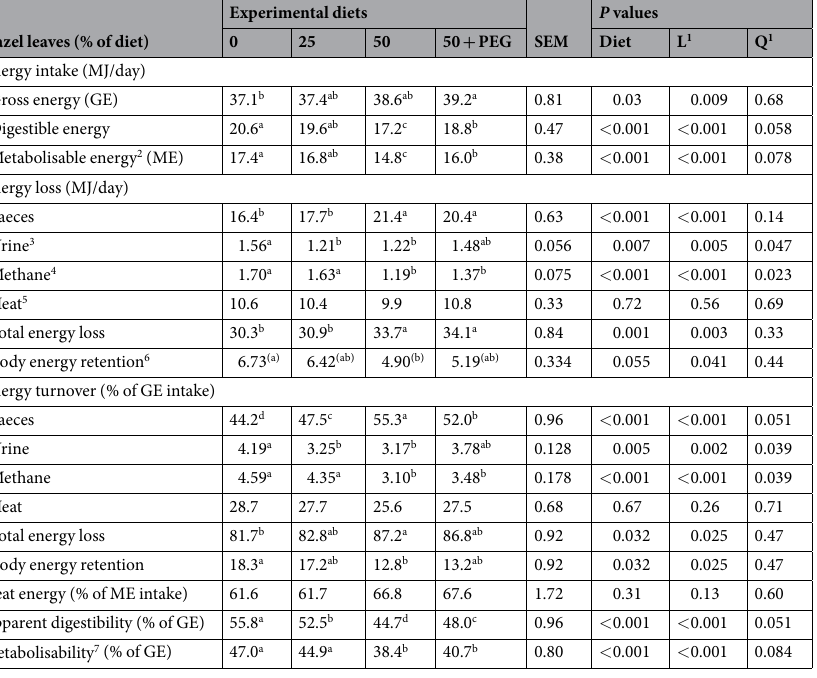
Table 5. Effect of hazel leaves on energy balance of sheep (n = 6). L, linear effect of hazel leaf proportion; PEG, polyethylene glycol; Q, quadratic effect of hazel leaf proportion; SEM, standard error of mean. Means carrying no common superscript without or with brackets are different at P < 0.05 and P < 0.10, respectively. 1 For this analysis, only diets 0, 25 and 50 were compared. 2 Metabolisable energy (ME; MJ/day) = GE